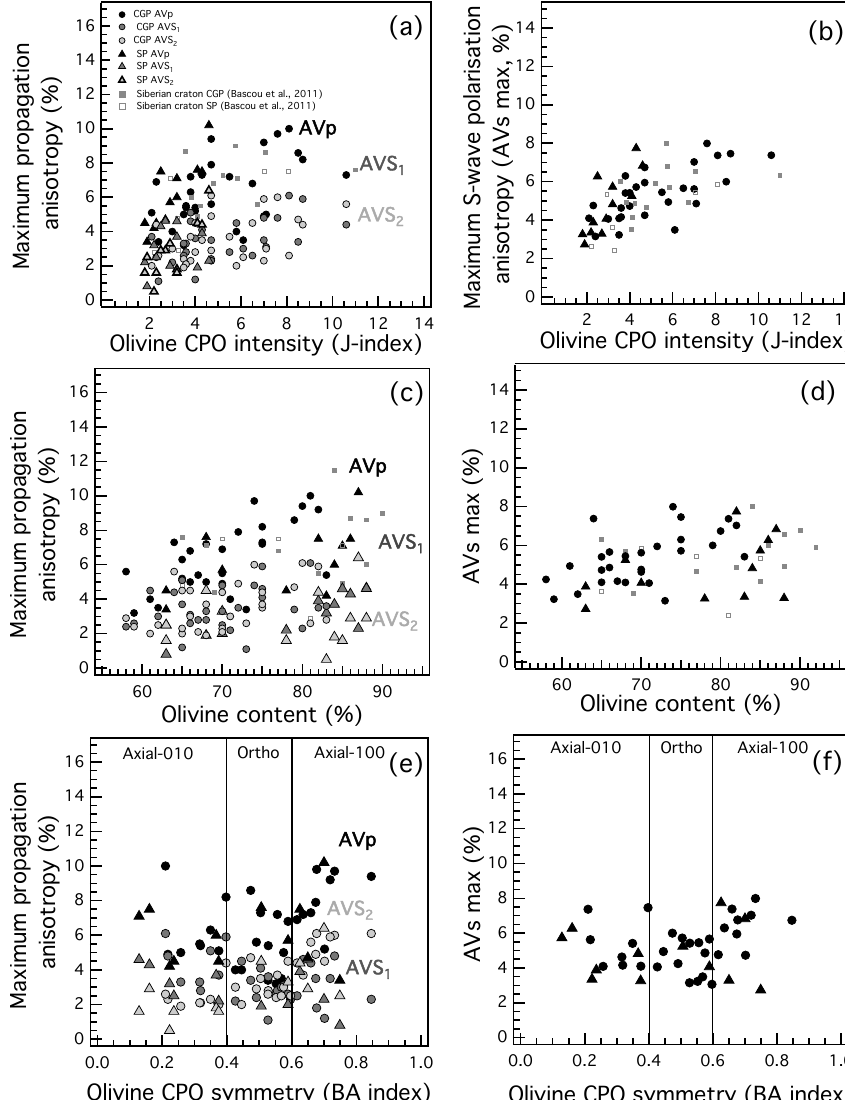
) , and of the maximum S wave polarization 2